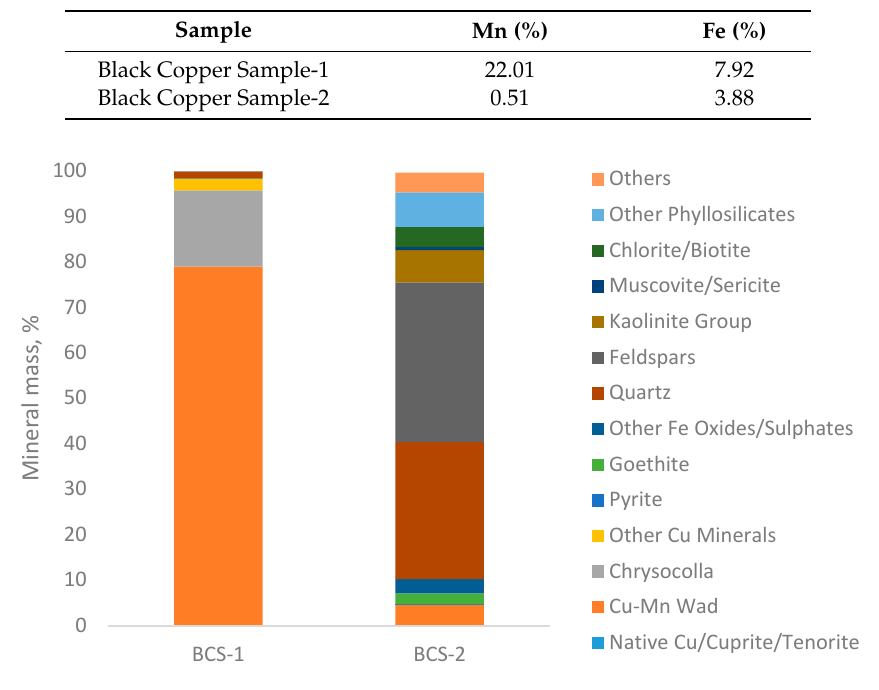
Figure 1. Detailed modal mineralogy.